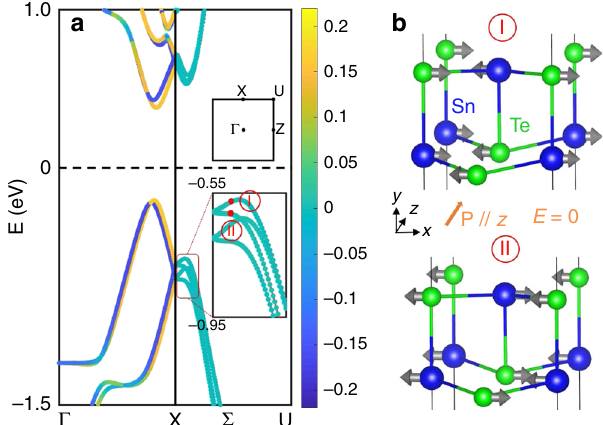
Fig. 4 BSVSP in 2D SnTe thin fi lm. a Band structure and the y components of spin polarizations of 2D SnTe thin fi lm calculated by DFT. Both x and z components vanish and are not shown here. b Local spin polarizations of Sn and Te atoms for the Bloch states marked with the red points I and II in a . The blue and green spheres are Sn and Te atoms, choose the polarization direction as the z axis, while the direction normal to the 2D thin fi lm is taken as the y axis (see Fig. 4b). In Fig. 4a we show the band structure around the X point, where four non-degenerate bands are found along the symmetry lines Σ (X → U) and Δ (X → Γ ), merging in two two-fold degenerate bands at the time-reversal invariant point X, labeled as ~ ~ , X , respectively. Along the Σ symmetry line, all components of X 3 4 spin polarization vanish, thus realizing the BSVSP effect. On the other hand, the bands along the Δ symmetry line are fully spin polarized along the y axis, as expected for a unidirectional Rashba effect, being the bands spin-polarization perpendicular to both k